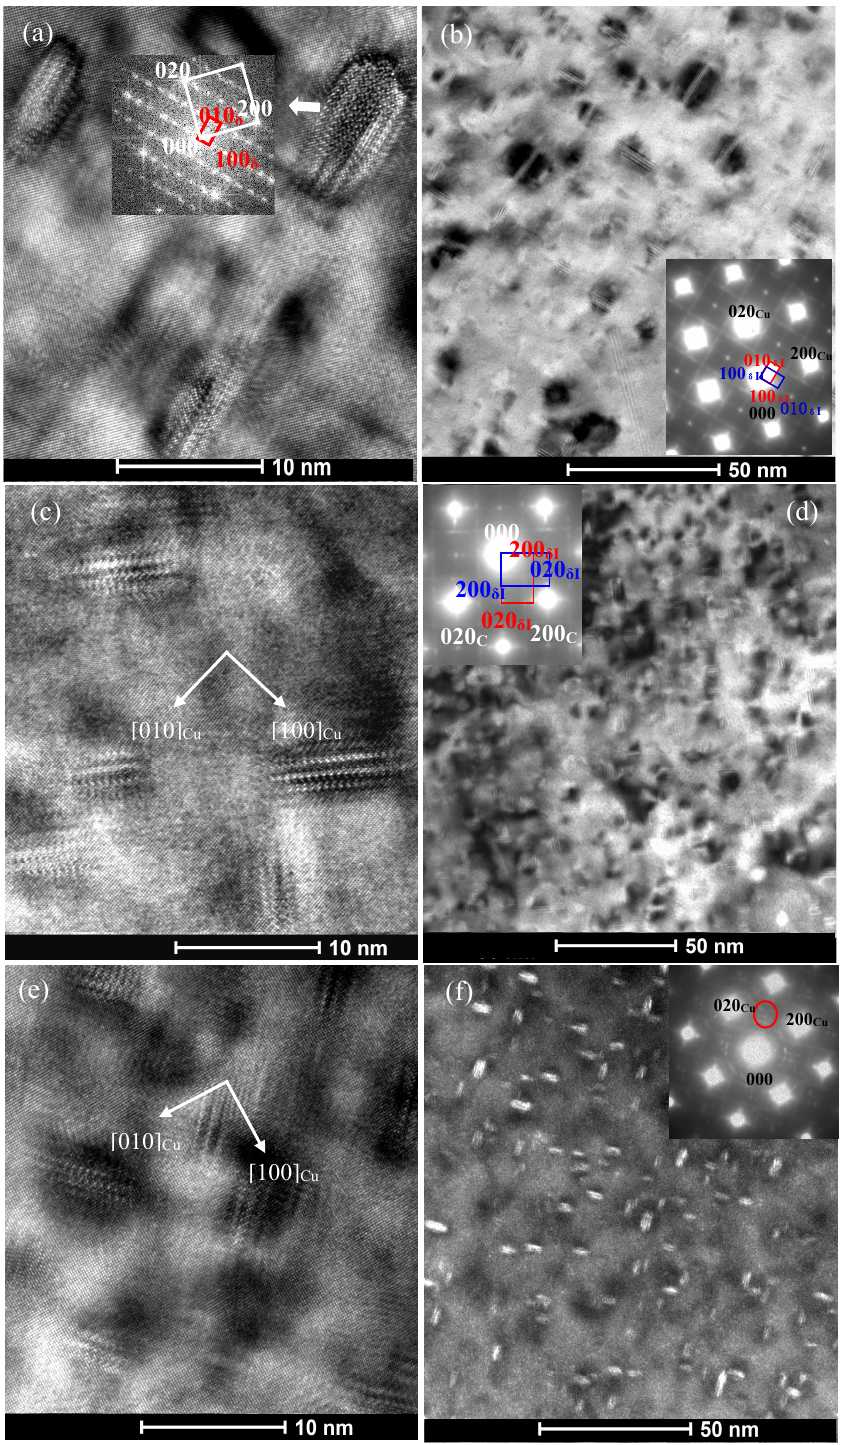
Figure 3. TEM images obtained from the C0, C1 and C4 alloys aged at 500 ◦ C for 0.5 h ( a ) HREM image of C0 alloy along [001] Cu zone axis and corresponding FFT pattern in the inset, ( b ) Dark field (DF) image of C0 alloy and corresponding [001] Cu pattern in the inset, ( c ) HREM image of C1 alloy along [001] Cu zone axis, ( d ) DF image of C1 alloy and corresponding [001] Cu pattern in the inset, ( e ) HREM image of C4 alloy along [001] Cu zone axis, ( f ) DF image of C4 alloy and corresponding [001] Cu pattern in the inset. The DF image was taken using precipitate (020) reflection marked by red circle in the inset. Red and blue rectangles refer to the diffraction pattern of two δ -Ni 2 Si variants and the same